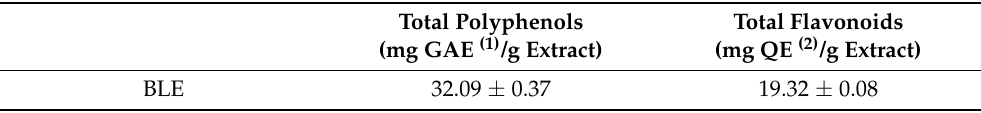
Table 1. Content of the total polyphenols and flavonoids in BLE.